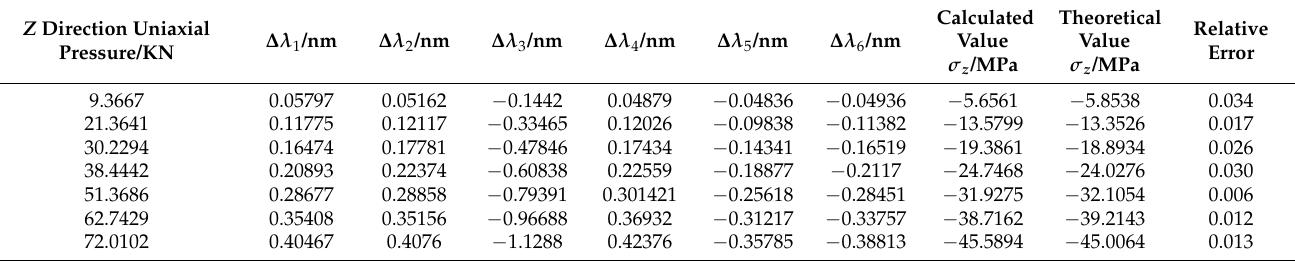
Table 4. Comparison between the experimental calculated value and theoretical